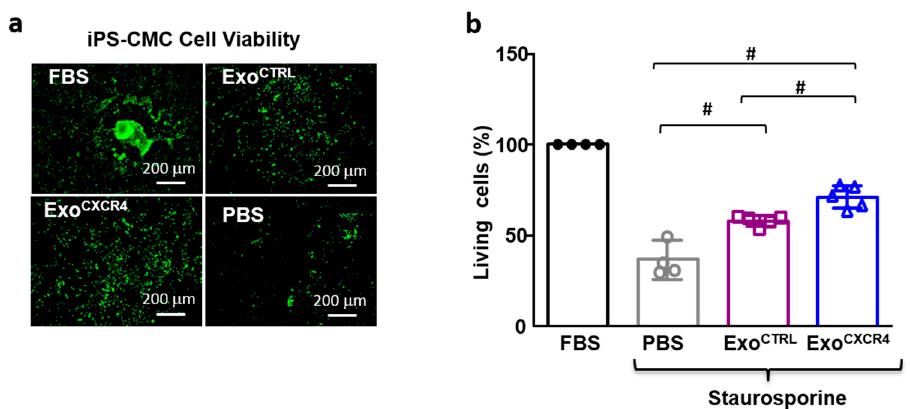
Figure A3. In vitro bioactivities of Exo CXCR4 . ( a ) Exo CTRL , and Exo CXCR4 inhibit staurosporine-induced death in human iPS-derived CM ( b ) ( n = 5 patients/group for Exo CTRL and Exo CXCR4 ; n = 4 repeated measurements for PBS and FBS) # p < 0.05 (one-way analyses of variance-ANOVA with post-hoc multiple comparisons using the Tukey-Kramer multiple comparisons test for paired parametric comparisons).